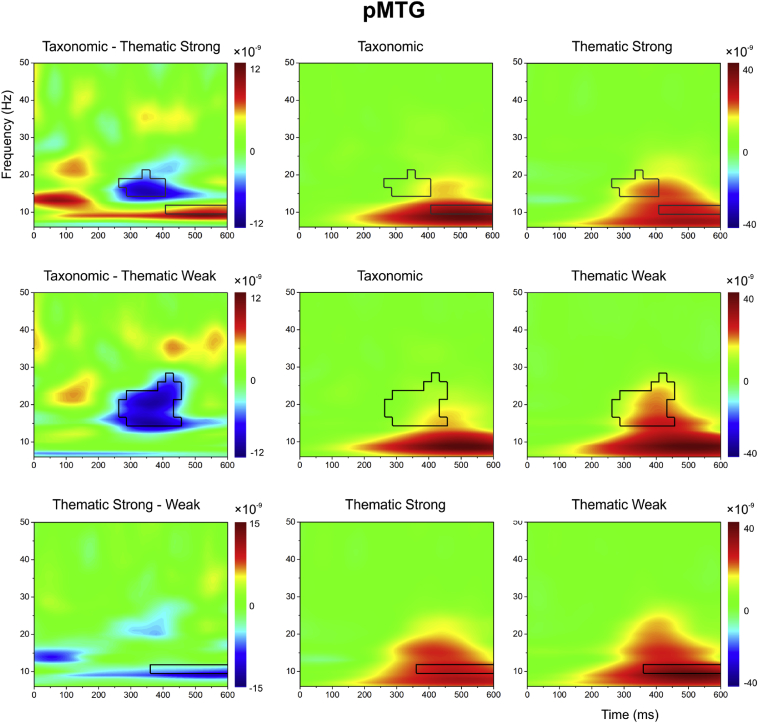
Evoked power in pMTG. Difference plots (left-hand column): Differences between taxonomic and strong thematic trials (TOP ROW), taxonomic and weak thematic trials (MIDDLE ROW) and strong versus weak thematic trials (BOTTOM ROW). The black lines mark statistical contours fulfilling the following criteria: a) the difference between conditions reached p < .05; b) the region was also significantly different from baseline in at least one of the two contributing conditions at p < .01; c) the cluster had six or more contiguous tiles showing a significant difference. The dotted lines show regions which fulfilled the first two criteria but had fewer than six tiles. The plots for each condition (middle and right-hand column) show signal change for each trial type relative to a “passive” baseline.